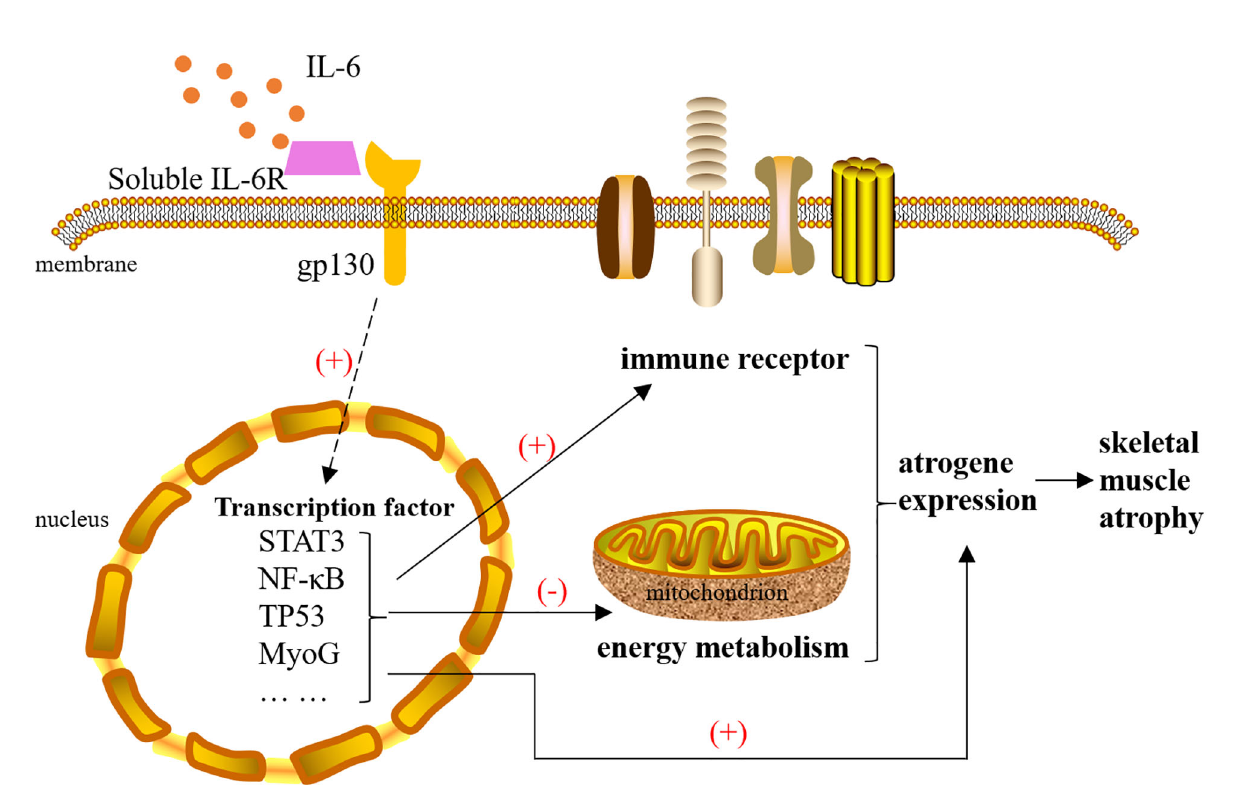
FIGURE 9 | The mechanism of interleukin-6 (IL-6) induced skeletal muscle atrophy. IL-6 signals are transmitted to the nucleus with the help of IL-6R and gp130, causing the activation of transcription factors, such as STAT3, NF- k B, TP53, and MyoG. These transcription factors cause changes in the expression of atrophy genes in three ways: 1) They can directly act on atrogenes. 2) They activate multiple immune receptors located on the cell membrane to amplify the immune response. 3) They inhibit mitochondrial function by reducing the expression of energy metabolism genes. Changes in the expression of atrogenes will cause skeletal muscle atrophy. IL-6,